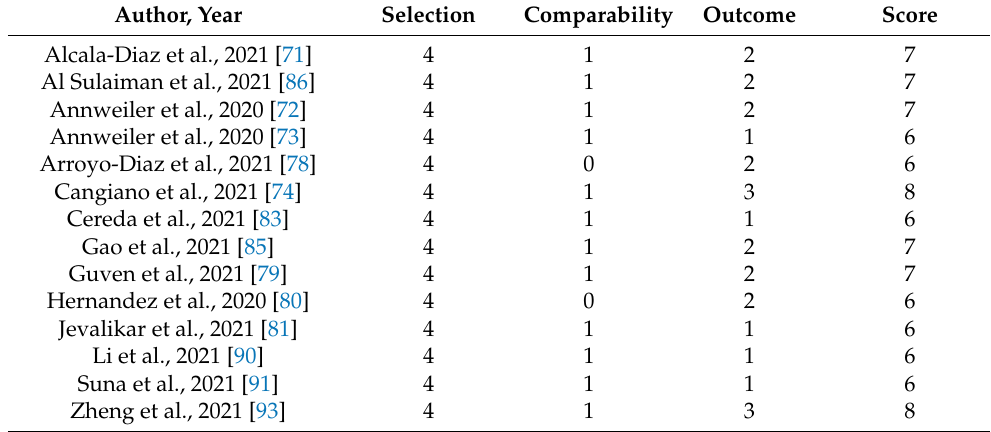
Table 3. Newcastle–Ottawa